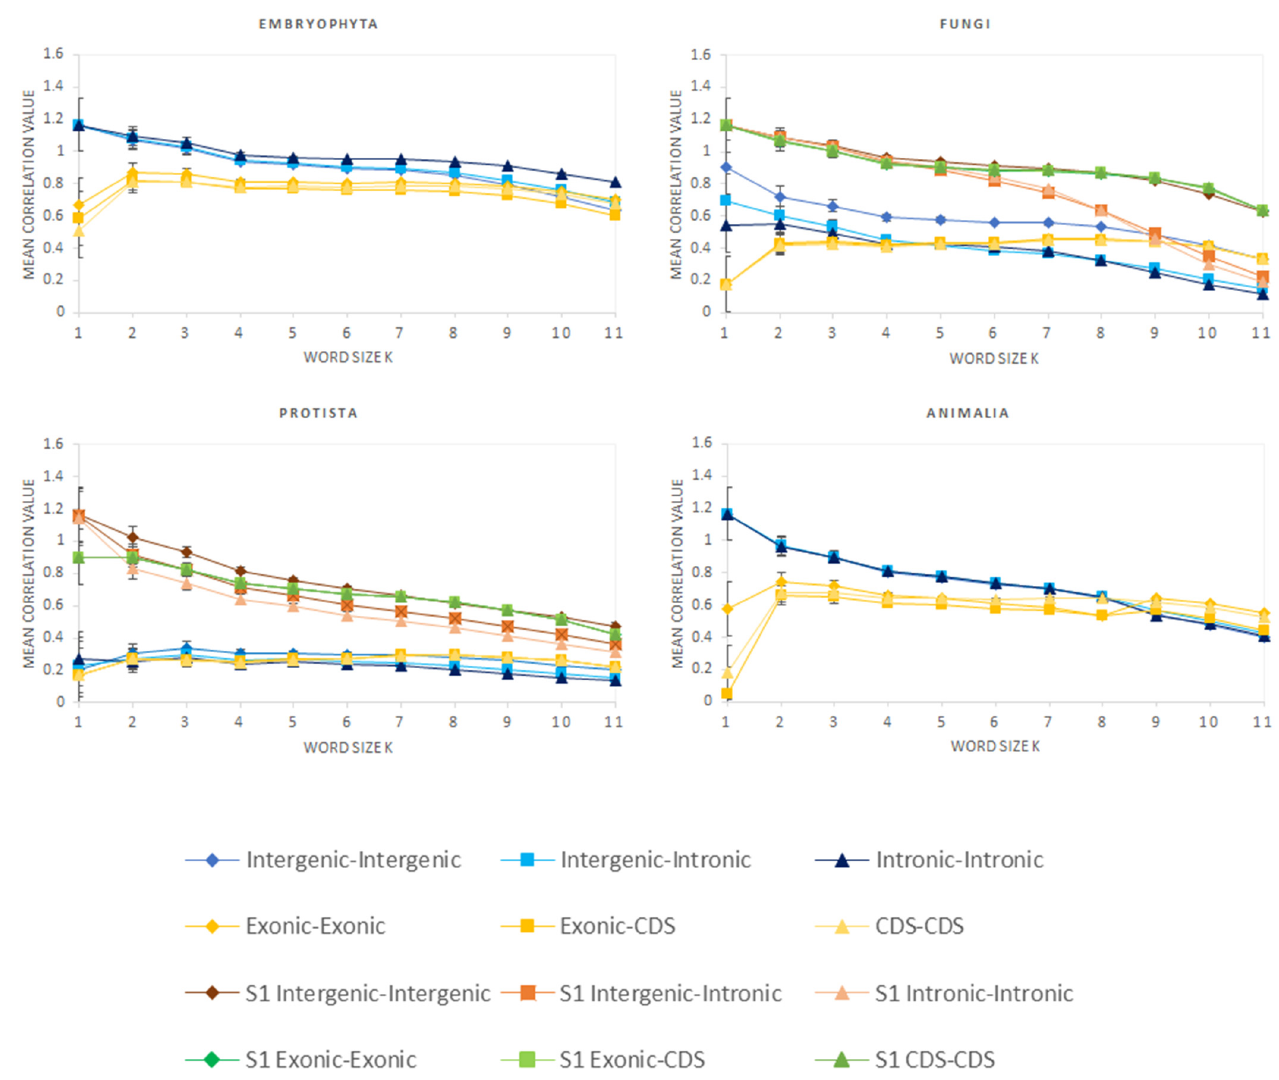
Figure 1. Mean correlation values (difference between genomic data and reference data) over all genomic sets against word length k (1 ≤ k ≤ 11). The error bars show the combined errors of modelled and real data. Mean correlation values may be above one as negative values may result from the models for the reference data. The curves labeled with “S1” show the results of a selection of a subgroup of higher correlating organisms in Protista and in Fungi . The y -axis is given for values above zero, and connecting lines between points were added for better readability.